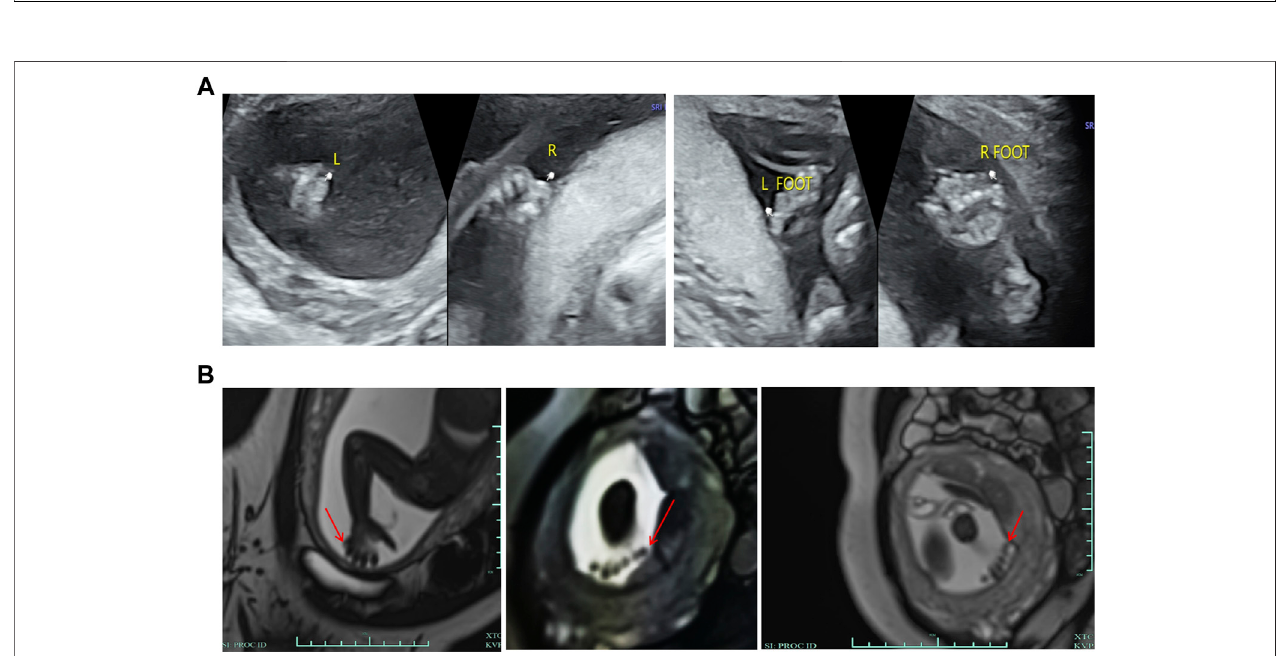
FIGURE 2 | Clinical features of the fetus. (A) Ultrasonography showed that there were echoes of the sixth toe on the lateral side of the little toe of both feet and the lateral side of the little fi nger of both hands, with a size of about 0.6*0.4 cm, and no obvious bony structure in them. (B) MRI showed a fi nger-like signal shadow on the outside of the right little fi nger, while the number of fi ngers on the left hand was not clear due to the position of the fetus. Six toe-like signal shadows were seen on both feet.